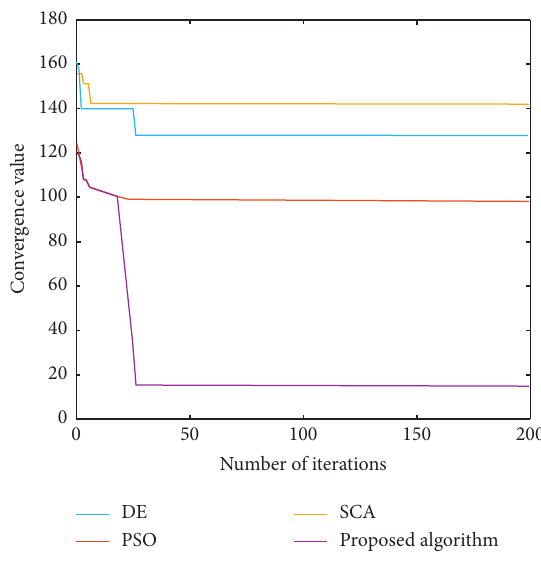
Figure 13: Convergence